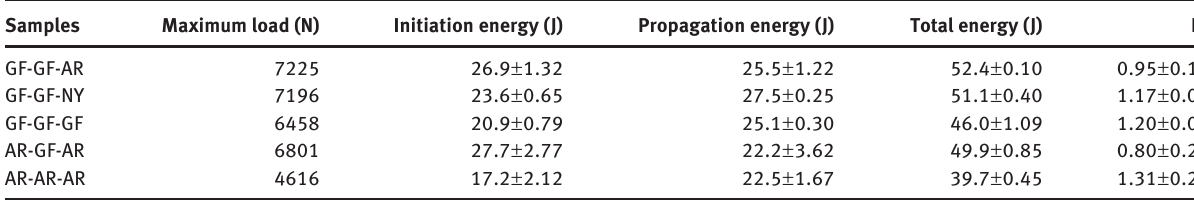
Table 3 Plate bending impact test results of BWK composites: effect of stitch and biaxial yarns.